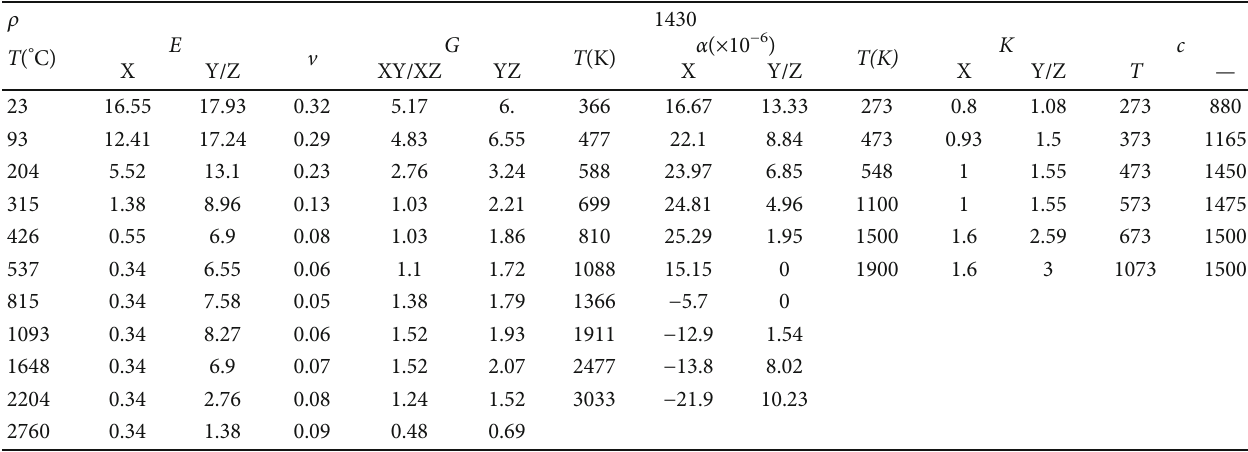
Table 2: Material properties of